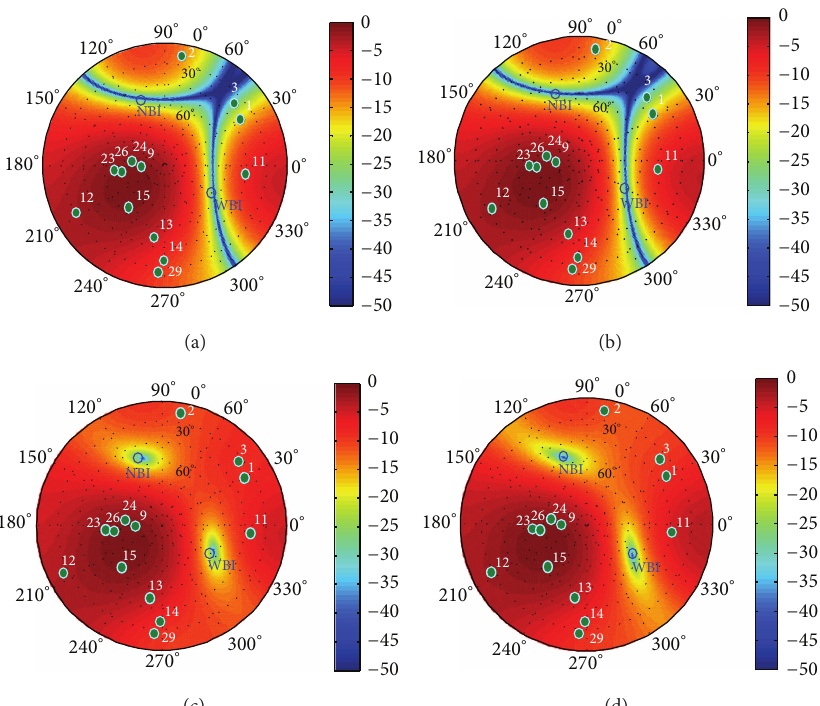
Figure 2: The gain patterns with and without compression measurement ( 𝐾 󸀠 = 3600 , 𝑄 = 17 , and 𝐵 = 200 ); (a) without compression measurement (4 antennas); (b) with compression measurement (4 antennas); (c) without compression measurement (9 antennas); (d) with compression measurement (9